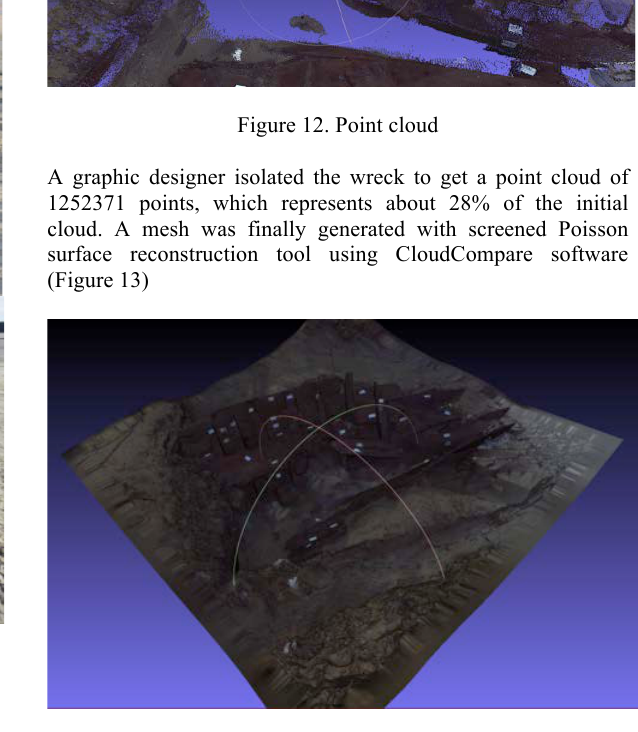
Figure 13. Mesh generated from laser